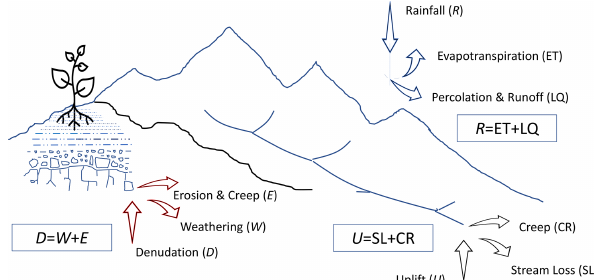
Figure 1. The three partitionings analyzed in this paper using di- mensional analysis: the rainfall partitioning taking place at the land surface, the soil mineral partitioning by chemical dissolution (weathering) and transport processes, and the related partitioning of soil sediments responsible for landscape evolution and the forma- tion of drainage